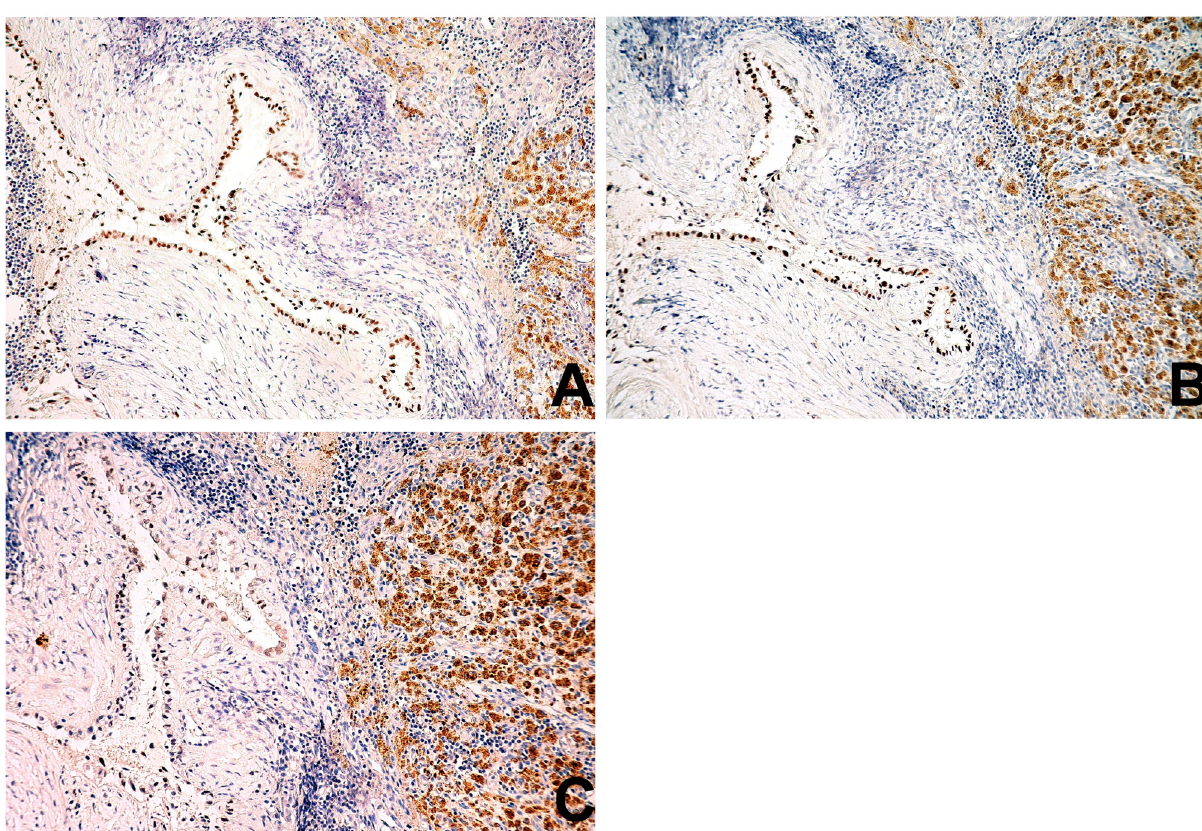
Fig. 2. Immunohistochemical expression of ER, PR and p53 in lymph node endometriosis. A: Strong nuclear expression of ER in more than 90% of endometrial glandular cells. Periglandular fibrosis, haemosiderin-laden macrophages and pseudoxanthoma cells are noted (immunohistochemistry, original magnification ×200). B: Strong nuclear expression of PR in more than 90% of endometrial glandular cells (immunohistochemistry, original magnifica- tion ×200). C: Weak nuclear expression of p53 in less than 1% of endometrial glandular cells (immunohistochemistry, original magnification